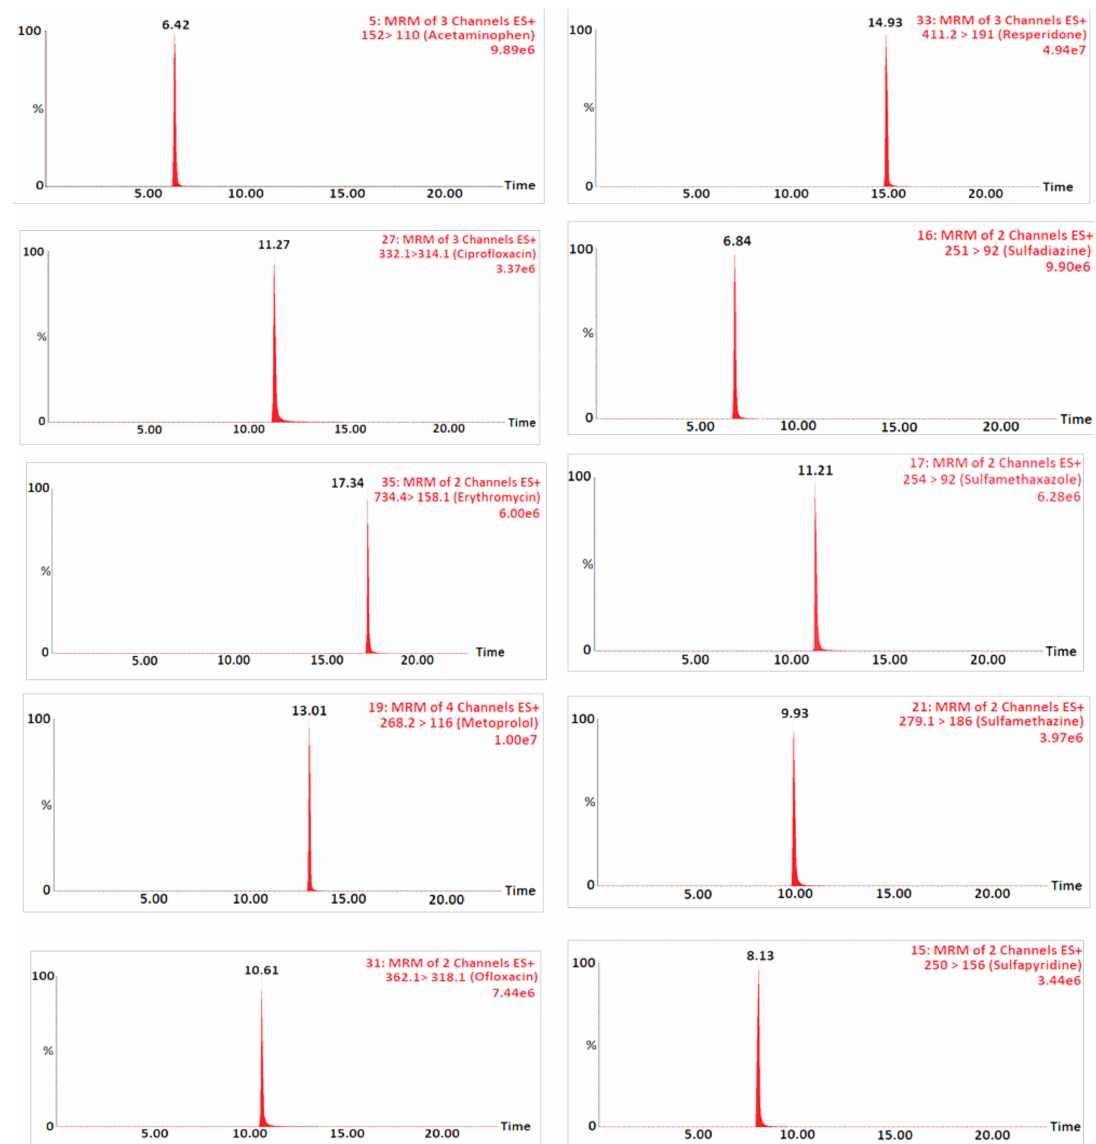
Figure 3. MRM LC-MS/MS chromatograms of the target compounds analyzed by positive ionization